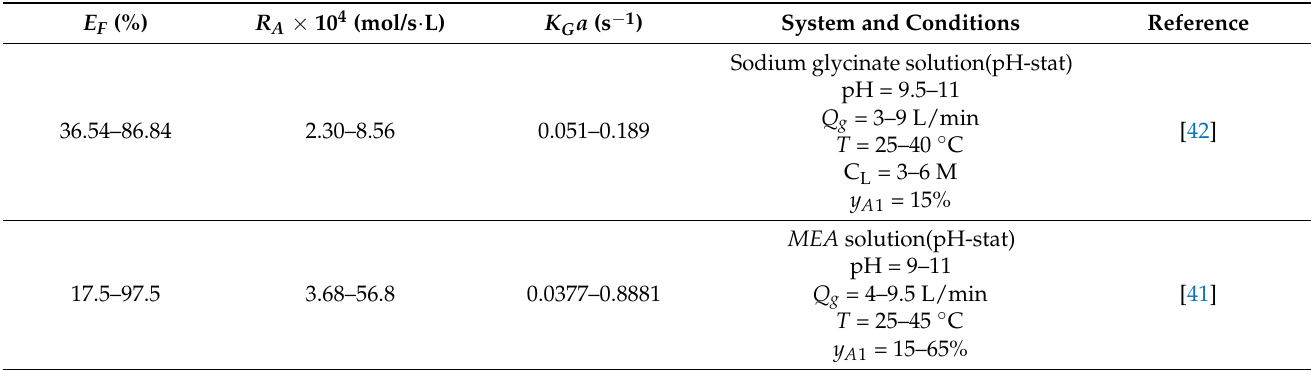
Table 5. Comparison of data obtained for different